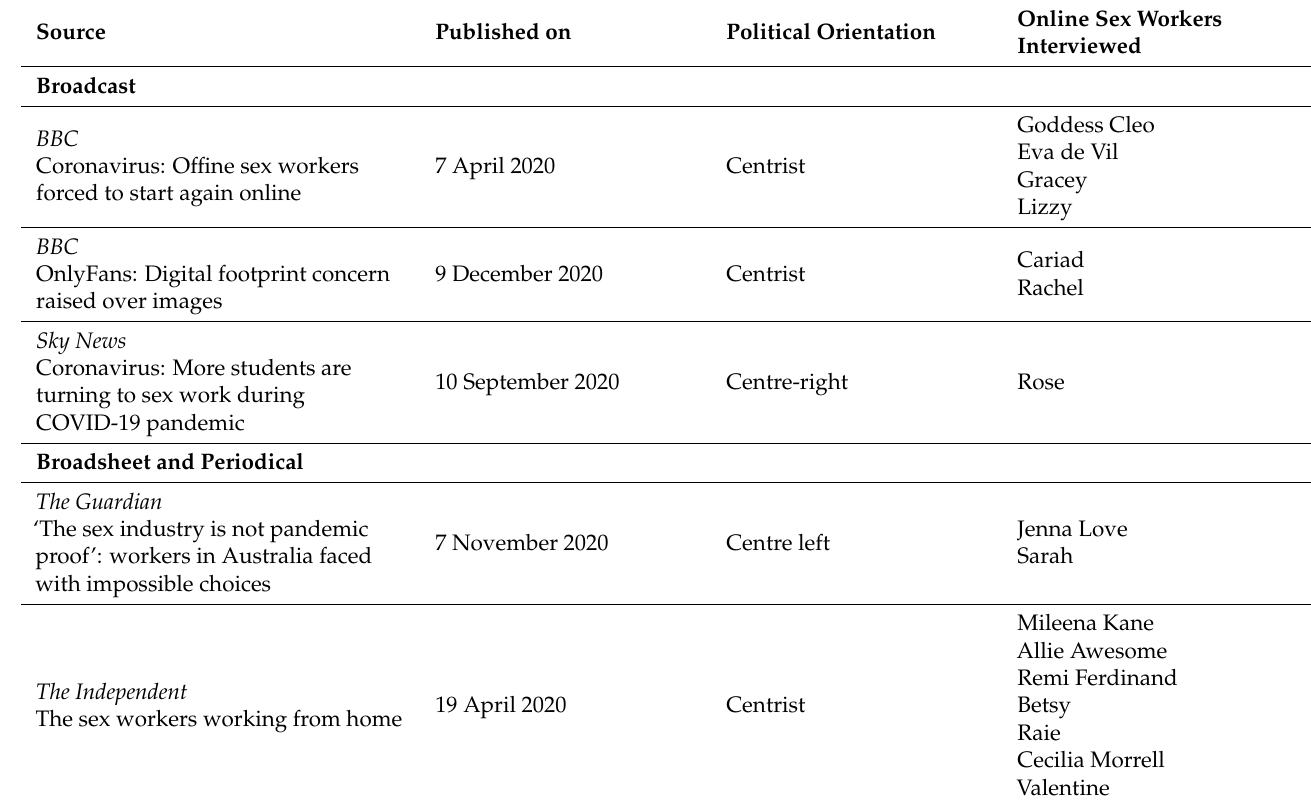
Table 2. Articles analysed in Study Two, Online sex work from January 2020 to May 2021, Publication dates, Political orientation and Workers